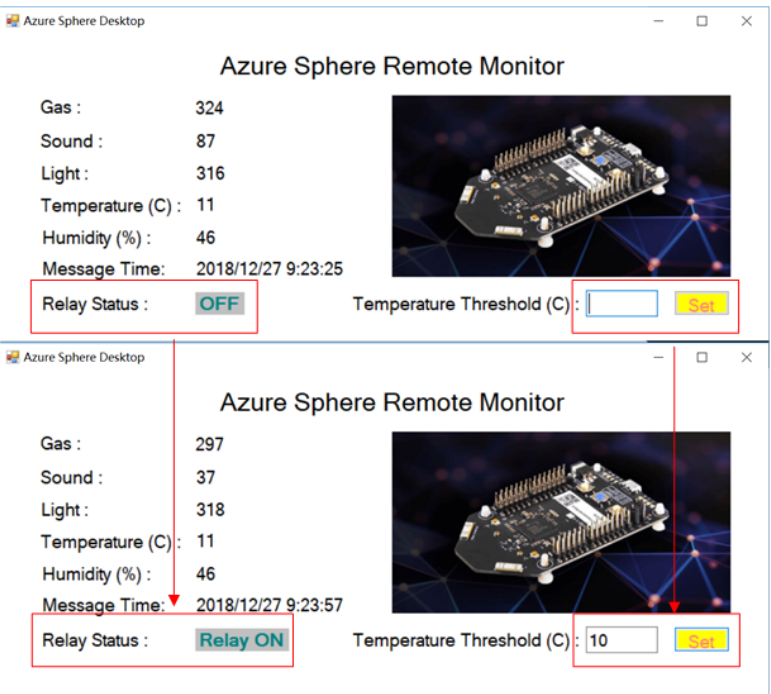
Figure 15. The layout of windows-form based native application.